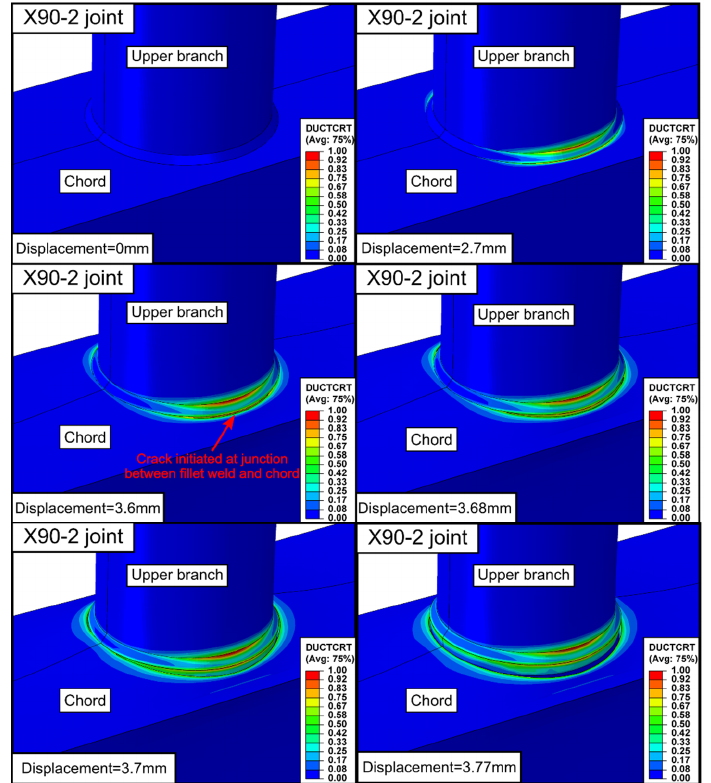
Figure 13. Fracture initiation and crack propagation of the X90-2 specimen simulated from the new fracture model.